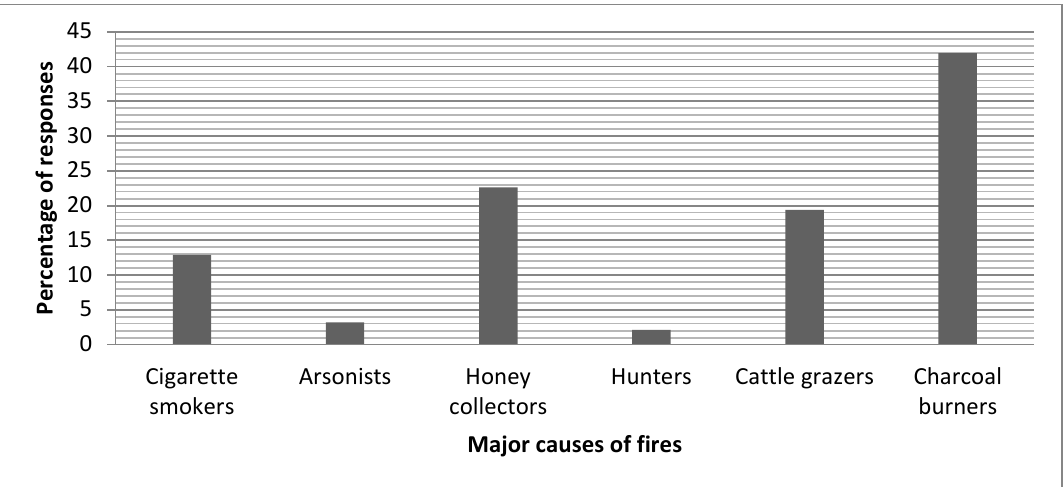
Figure 3. Major causes of fires in Gathiuru Forest indicated by questionnaire respondents (N =